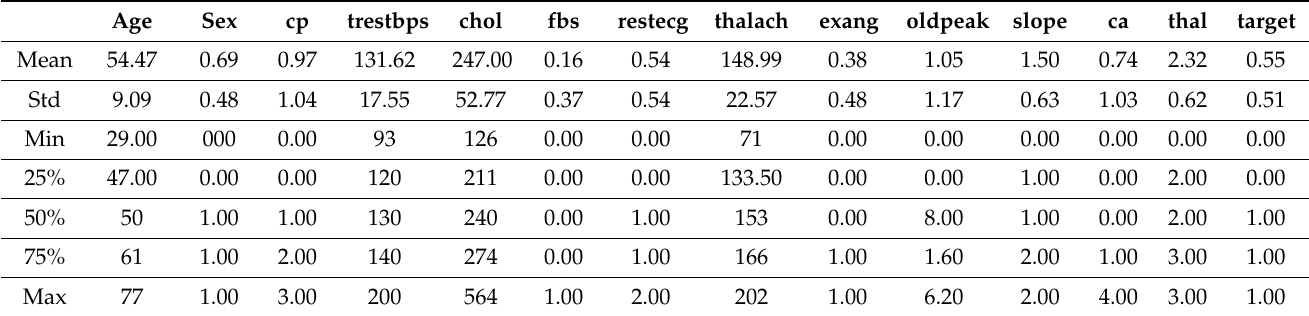
Table 2. The description of dataset-I for the count (303), minimum, maximum, mean, and standard deviation.